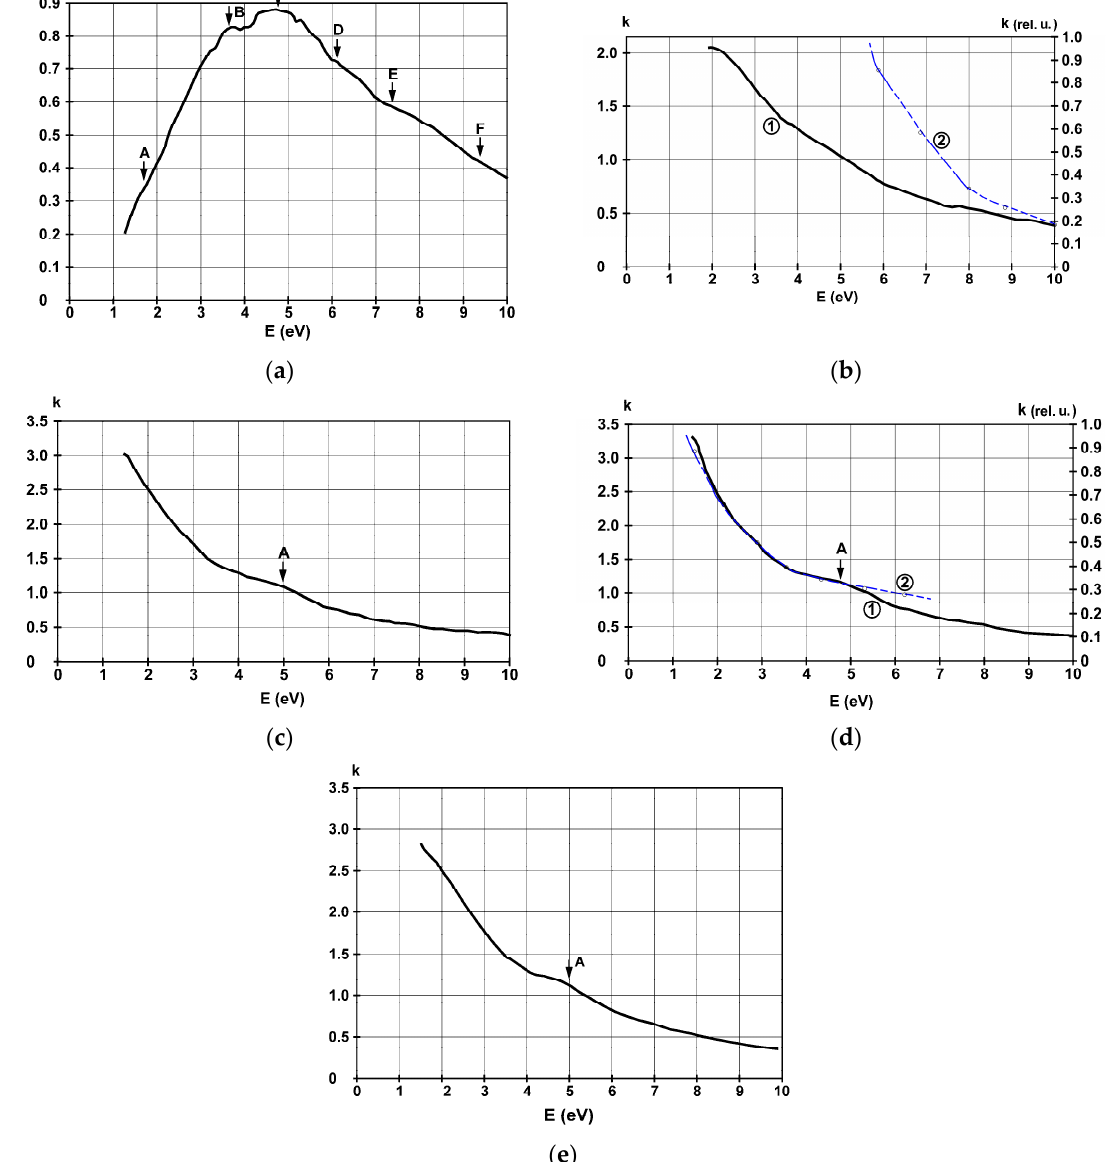
Figure 8. Spectral dispersion of the extinction coefficient k for the films deposited on glass substrate with thicknesses of ( a ) 4.5 nm, ( b ) 22 nm, ( c ) 38 nm, ( d ) 42 nm, and ( e ) 36 nm on SiO 2 . The blue curves are computed from theory using the free electron approximation. Table 2. Computed skin depth of a 500 nm incident electromagnetic radiation.